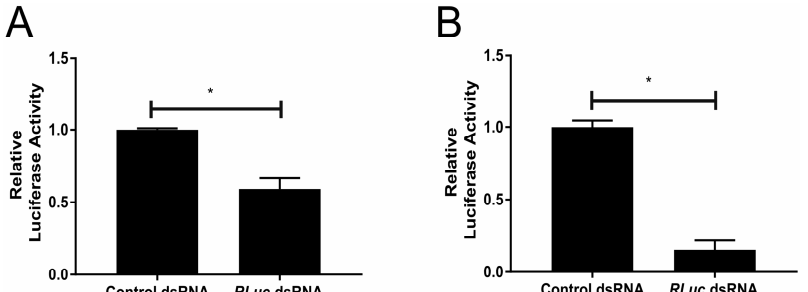
Figure 4. TRA-171 cells possess a dsRNA-inducible antiviral RNAi pathway. The cells were transfected with dsRNA against either RLuc or eGFP (as a control) 24 h prior to being either mock infected or infected with SFV(3H)- RLuc at MOI 10 ( A ) or 0.005 ( B ). Luciferase expression was determined by luciferase assay 24 h p.i. and luciferase activity is shown on the Y-axis. Mean values with standard error are shown for three independent experiments performed in triplicate. The analysis used the average of each triplicate per experiment. * indicates significance, p < 0.05 by Student t